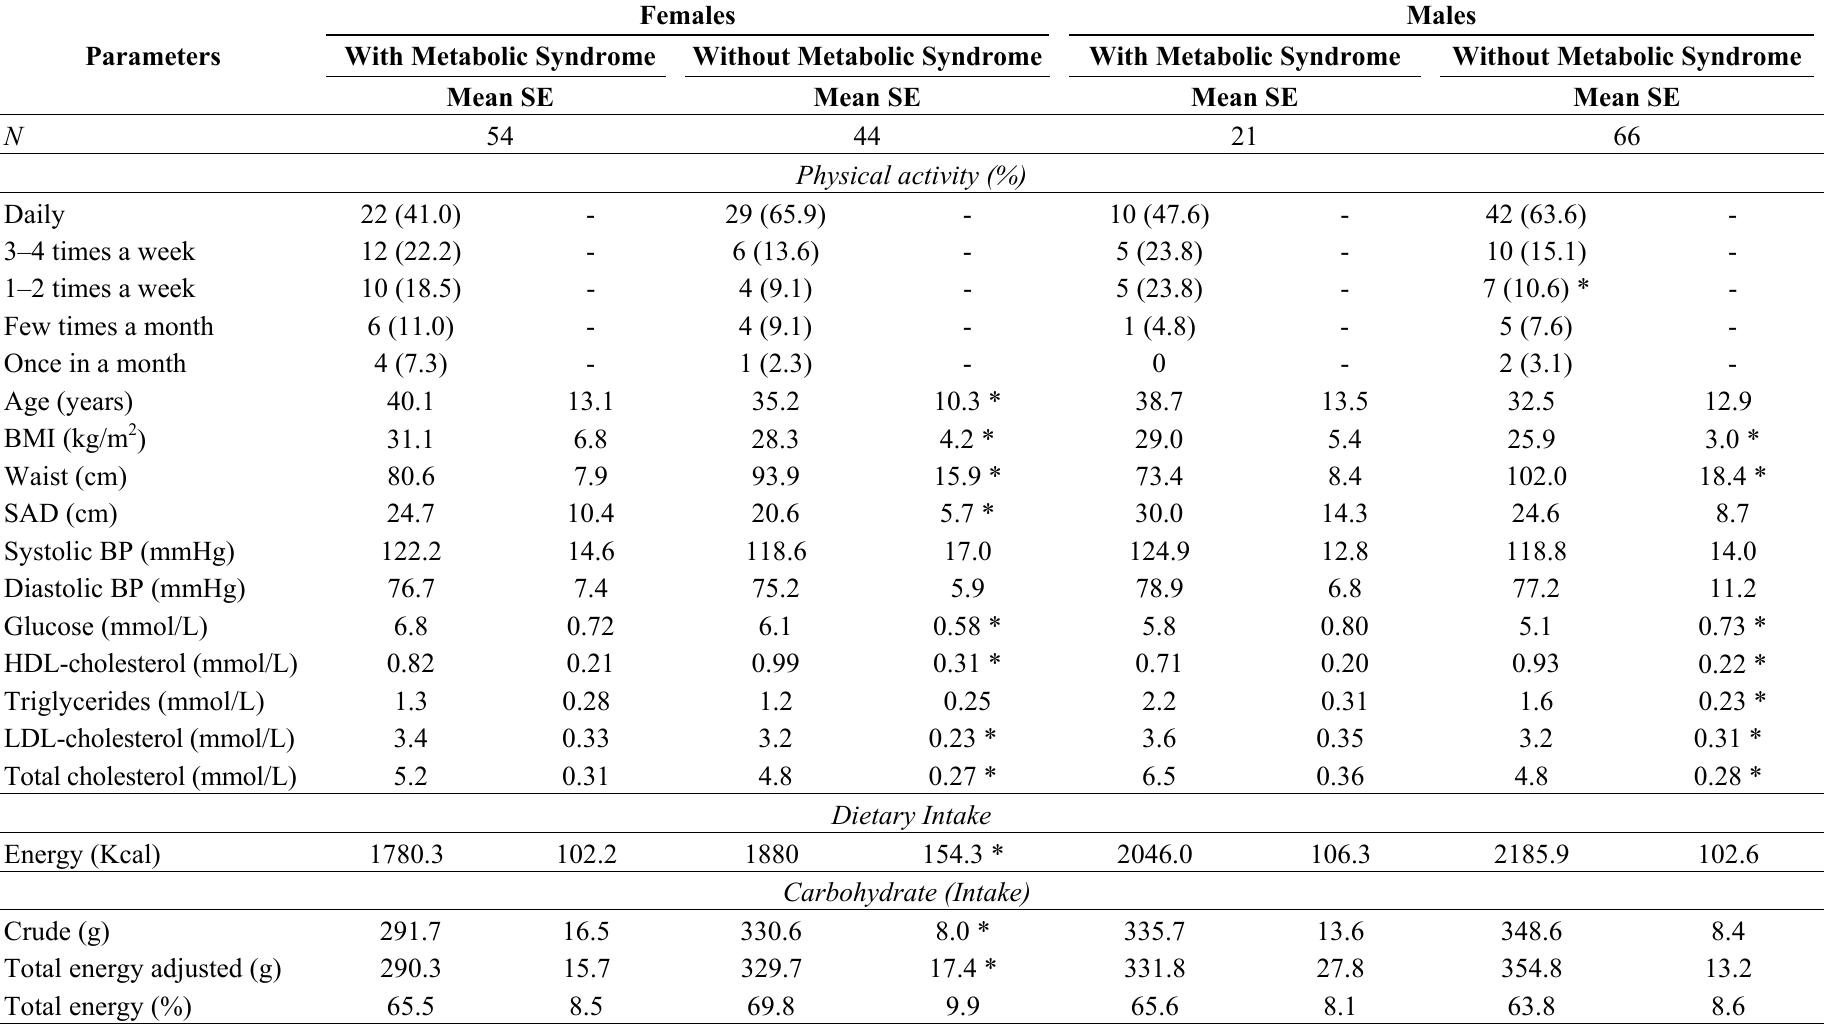
Table 3. Daily intake of energy and selected nutrients of the study participants according to gender. Females Parameters